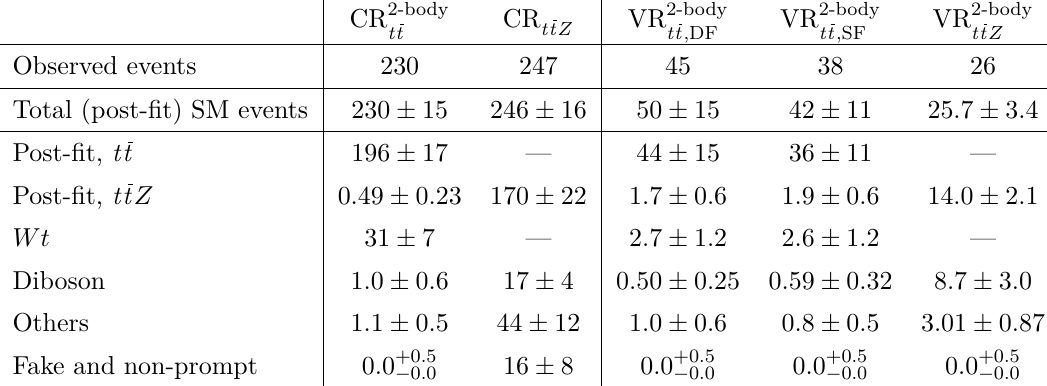
Table 7 . Two-body selection. Background fit results for CR 2-body VR 2-body tt